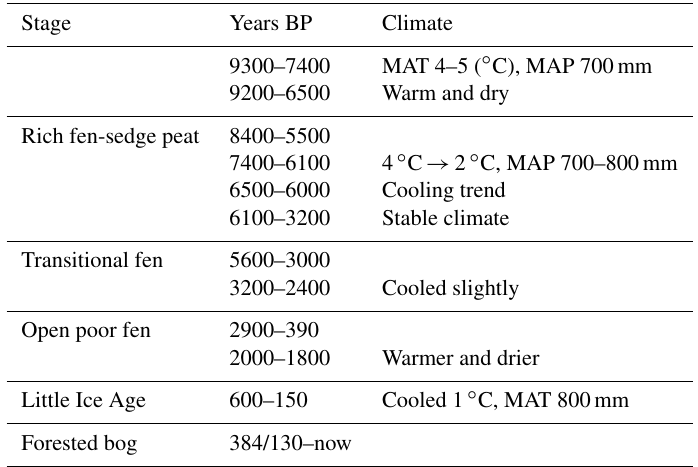
Figure 1. Conceptual diagram of movement of carbon (C) and nitrogen (N) during peatland development from rich fen to bog. Major pro- cesses influencing isotopic composition include methane (CH 4 ) flux from surficial and deeper layers (dotted upward arrow), methanotrophy and subsequent CO 2 recapture by Sphagnum , vascular plant transport of methane, N uptake by vascular plants and mycorrhizal fungi, and the sequestration of C and N over time in deeper peat. Assimilation of 13 C-depleted CO 2 from the Suess effect influences modern peat carbon (rightmost top box); N flux from adjacent uplands influences productivity in the lagg region, peatland topography of hummocks and hollows influences methanogenesis and methanotrophy, and trees influence partitioning of nitrogen. Climate (not shown) will influence the initial δ 13 C of fixed carbon. By rotating the figure 90 ◦ counterclockwise, the lower boxes correspond stratigraphically to the peat profile. Table 1. Peatland stages at SPRUCE based on stratigraphy at the S2 watershed in the Marcell National Forest, USA (Verry and Janssens, 2011). MAT: mean annual temperature; MAP: mean annual